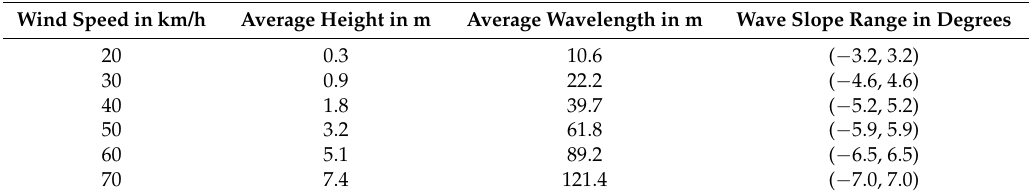
Table 8. Wind speed and the parameters of its resulting waves.